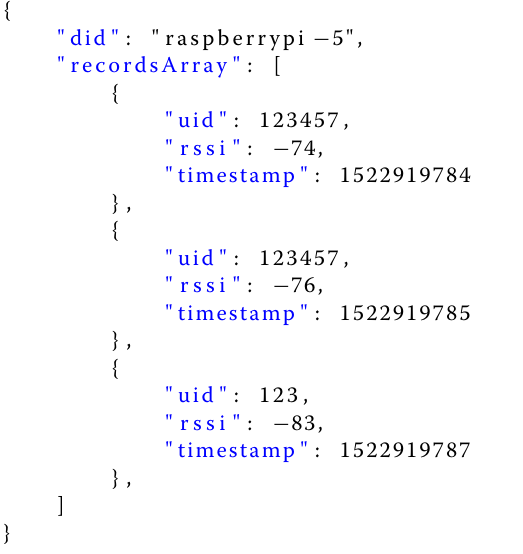
lectors’ measurements rssi, did for a specific user within a specific timespan (defined by a timestamp, commonly the time that the timespan